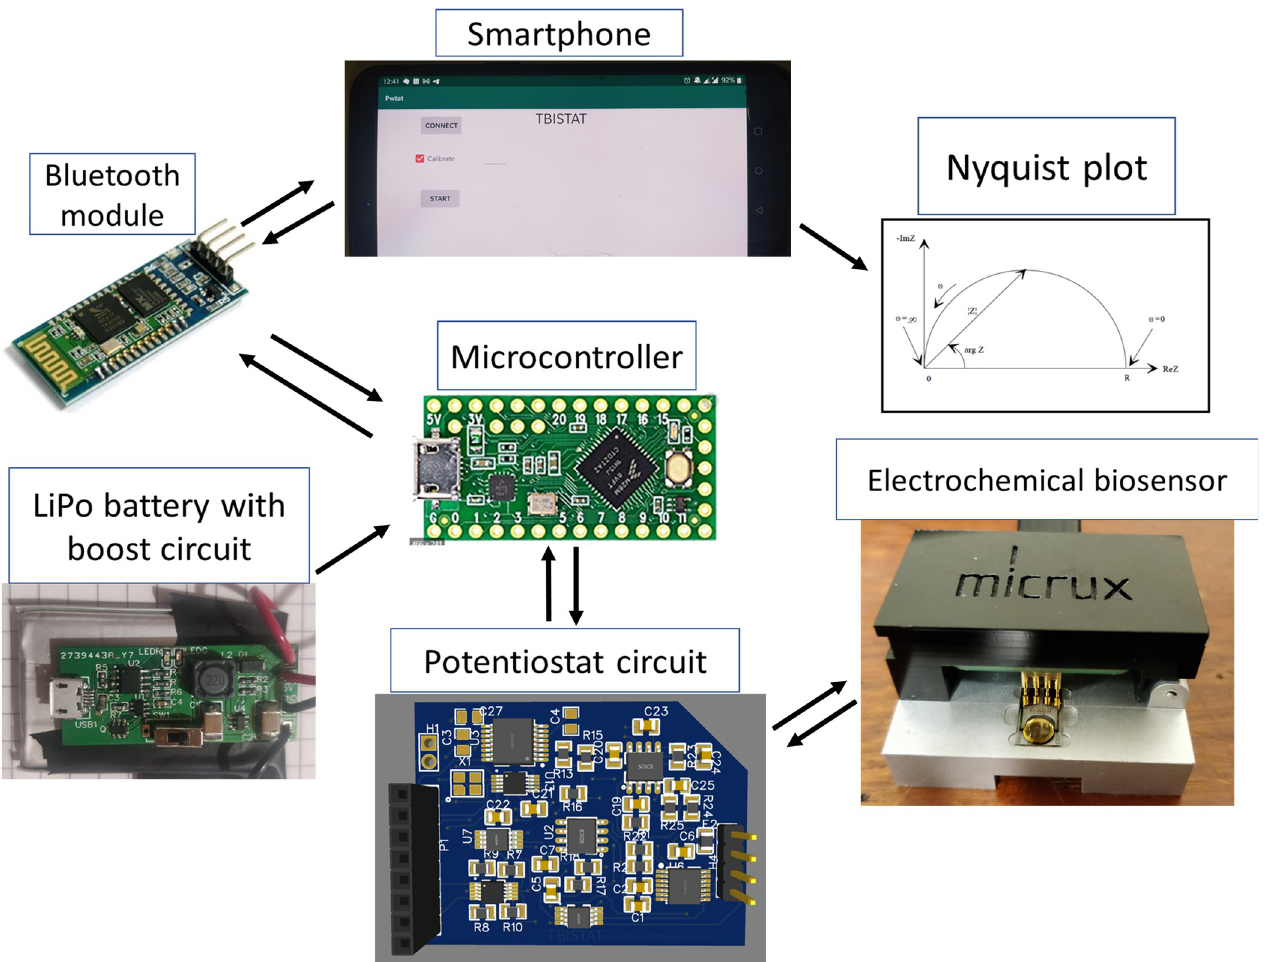
Fig 2. General representation of the system components. smartphone receives the input parameters of the experiment from the user, communicates the experimental protocol to the TBISTAT, receives the raw data (ADC) of the EIS measurement, and visualizes it for the user in a real-time Nyquist plot. The modules HC06 and HM-10 were used for performing wireless communication between TBISTAT and a smartphone. Communication between BMs and MCU is done using the universal asynchronous receiver/transmitter (UART) interface, which is a block of circuitry responsible for imple- menting serial communication using two channels, one for transmission (Tx) and one for reception (Rx). Both modules permit serial transfer as high as 115200 Bauds. Additional details about the BMs technical specifications are found in S1 File.